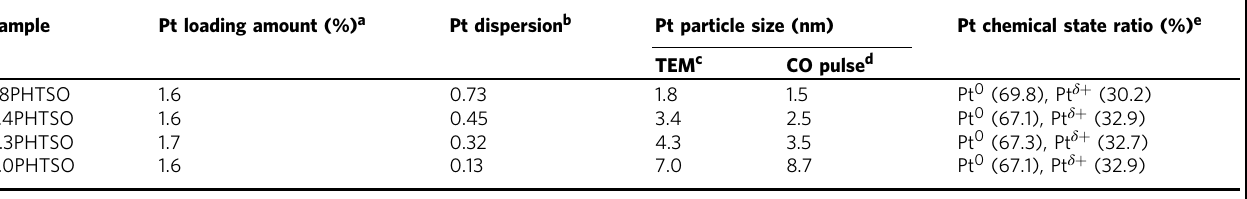
Table 1 Characterizations of Pt NPs in the x PHTSO ( x = 1.8, 3.4, 4.3, and 7.0)